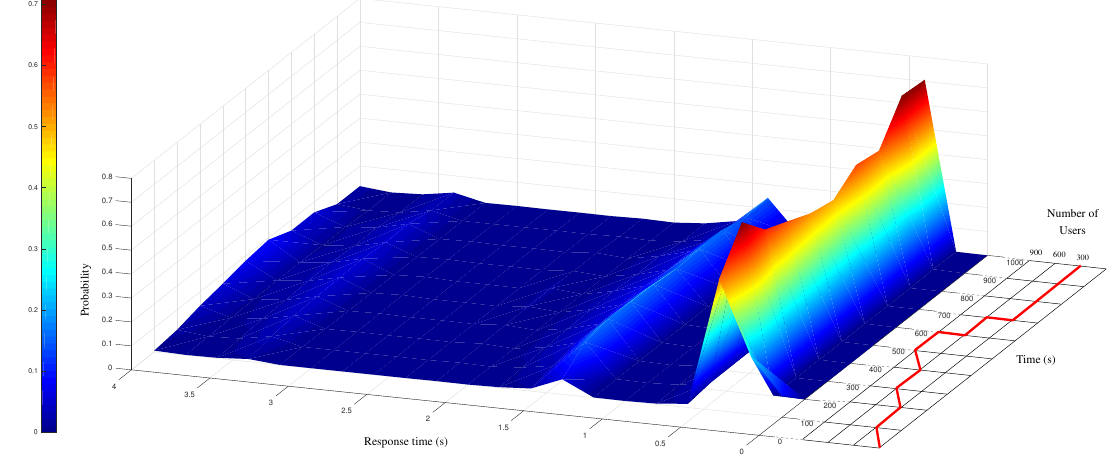
Figure 11. Probability-density function (95% of the response time values) considering the request given in Figure